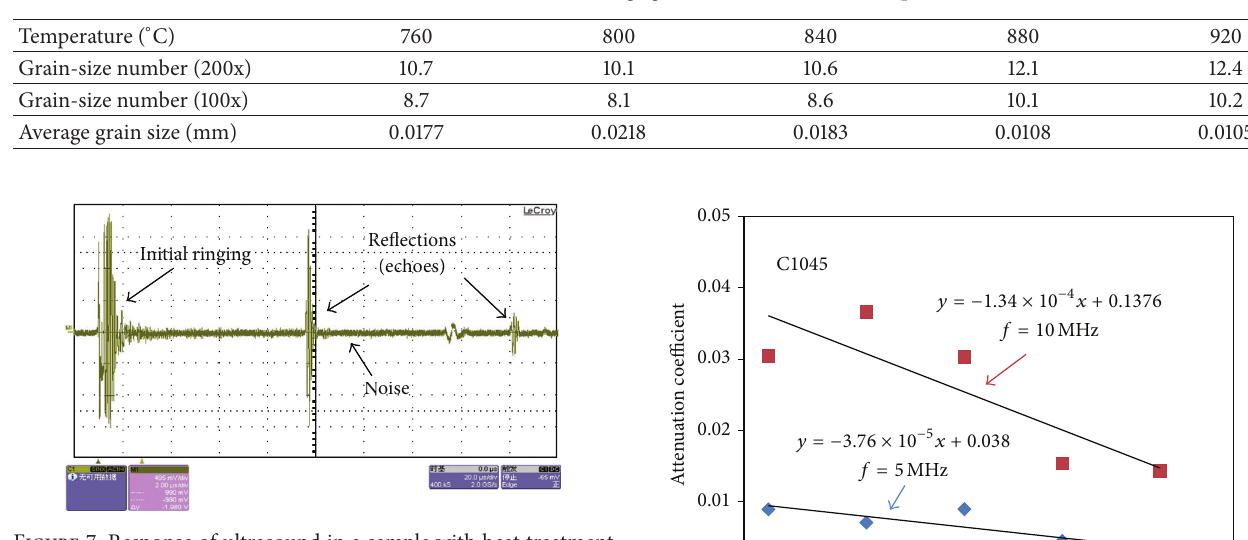
Figure 7: Response of ultrasound in a sample with heat treatment 760 ∘ C and 10MHz. Scattered waves appear as noise superimposed on the multiple front and back echoes.